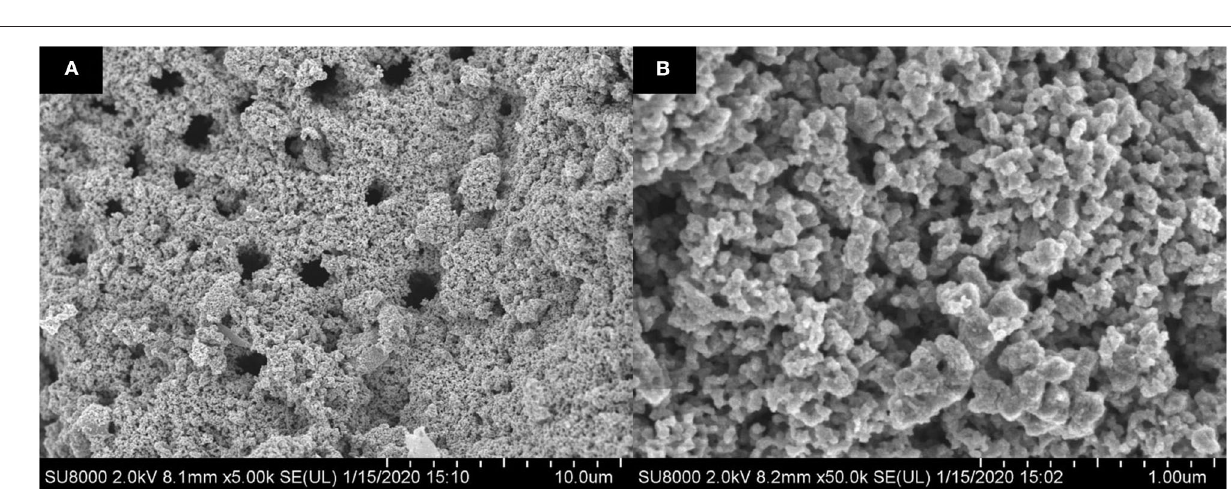
densely aggregated, with non-uniformed semi-spherical